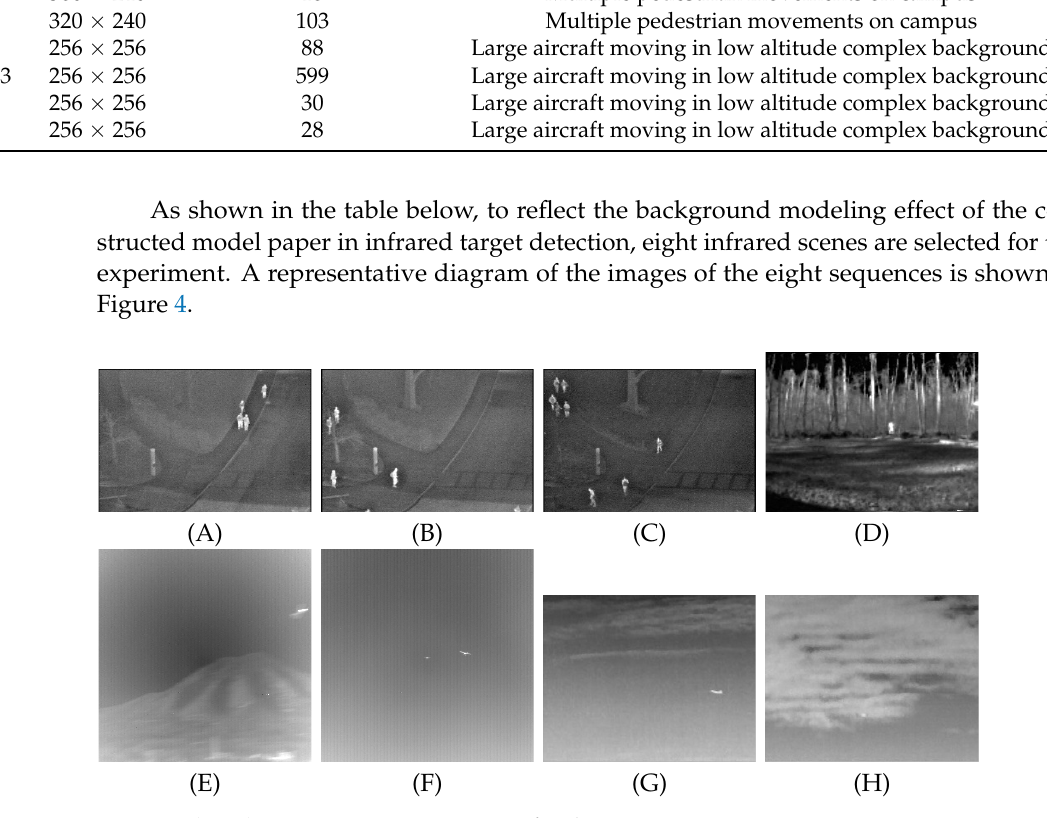
Figure 4. ( A – H ) are representative images of eight